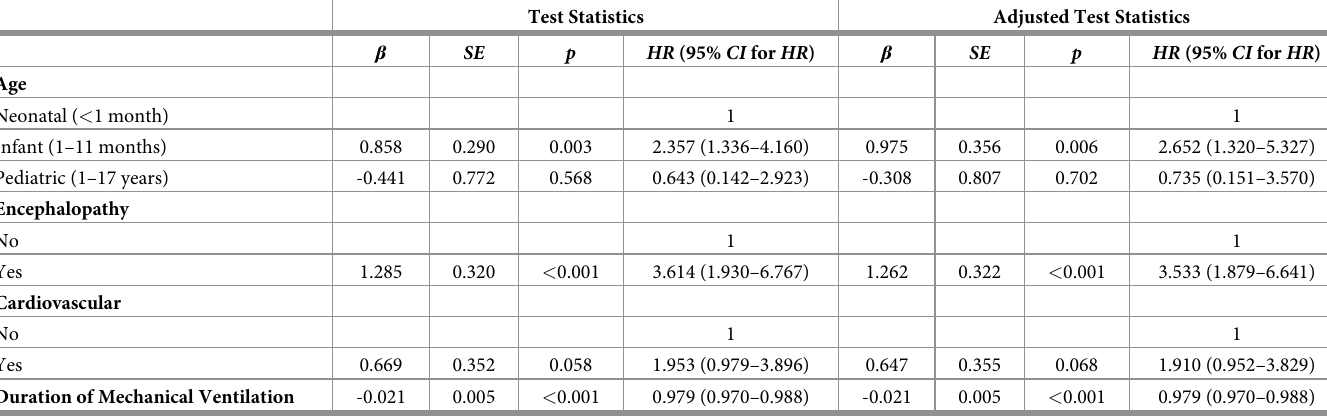
Table 4. Hazard rate and adjusted hazard rate (HR) estimations for risk factors on survival using univariate Cox proportional hazard model.